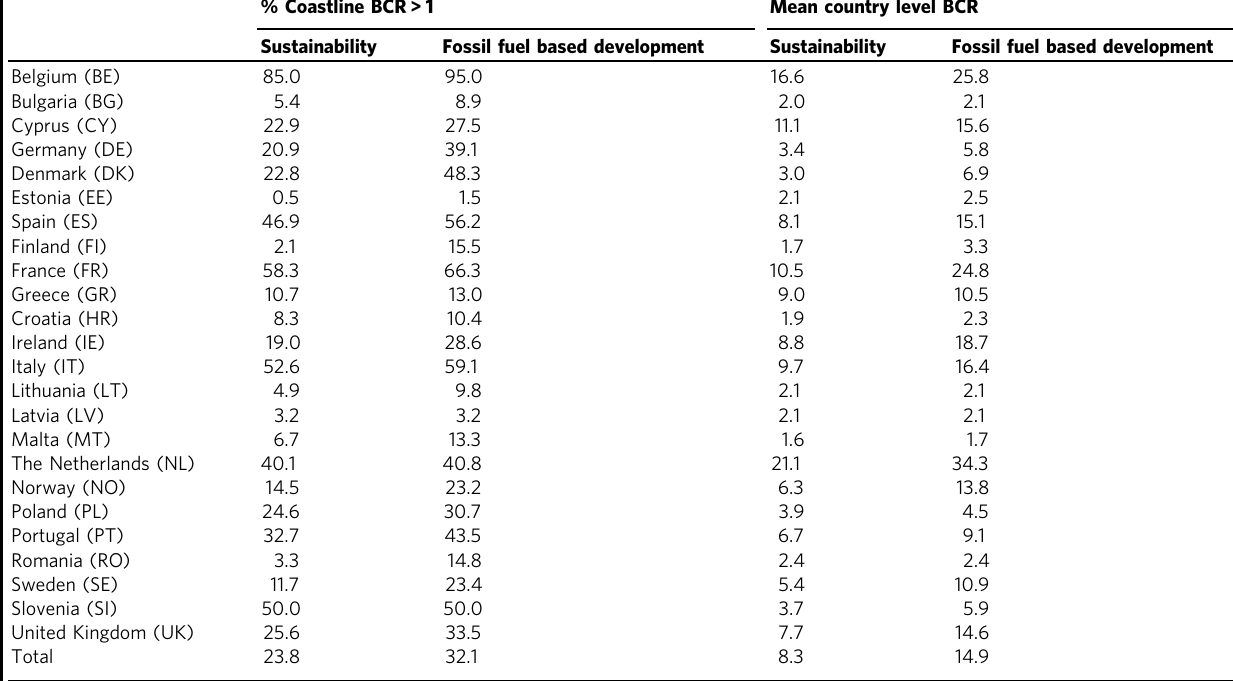
Table 3 Bene fi ts vs Costs at country